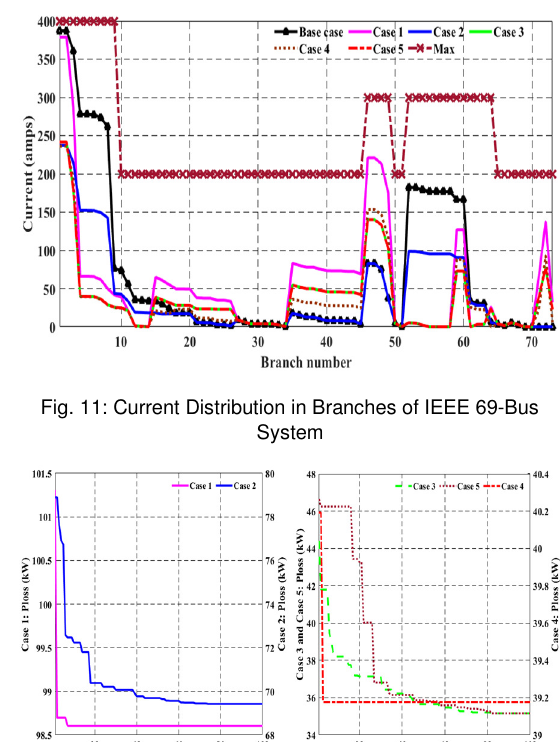
Fig. 10: Bus Voltage Profile of Case 1 to Case 5 for IEEE 69- Bus System